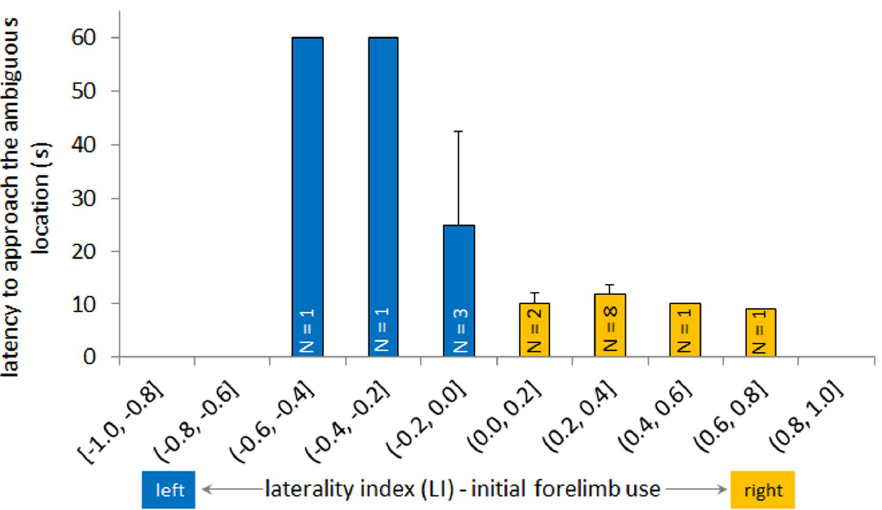
Figure 1. Mean latency to approach the test box in the ambiguous location compared to the initial forelimb use. Horses with a laterality index of the initial forelimb use lower than 0 (blue) started walking from the starting position more often with the left forelimb, and horses with an index higher than 0 (yellow) started more often with the right forelimb (GLMM: ambiguous box ~ initial forelimb use, N = 17, t = −3.71, p = 0.002). Horses which needed more than 60 s were considered not to have made a spontaneous decision (i.e., three horses: one horse at (−0.6, −0.4], one horse at (−0.4, −0.2], one horse at (−0.2, 0.0]). The mean latency and the standard error are shown. GLMM: generalized linear mixed model.